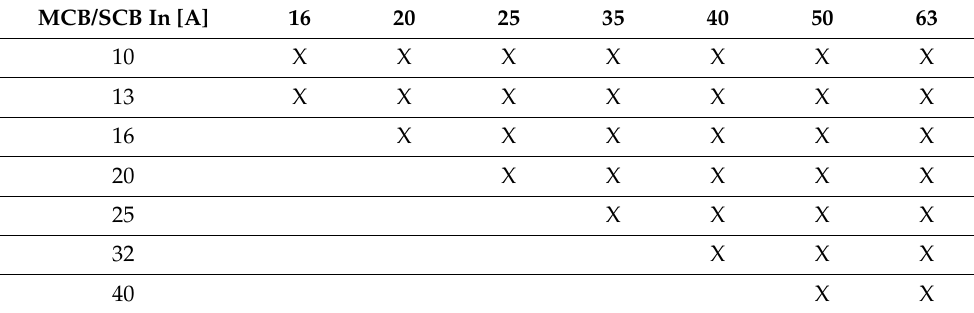
Table 4. Proposed new coordination table.